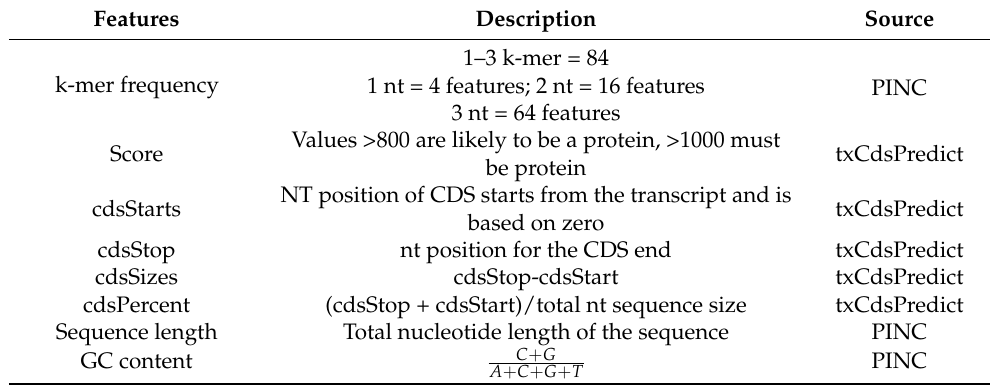
Table 7. All features considered in this